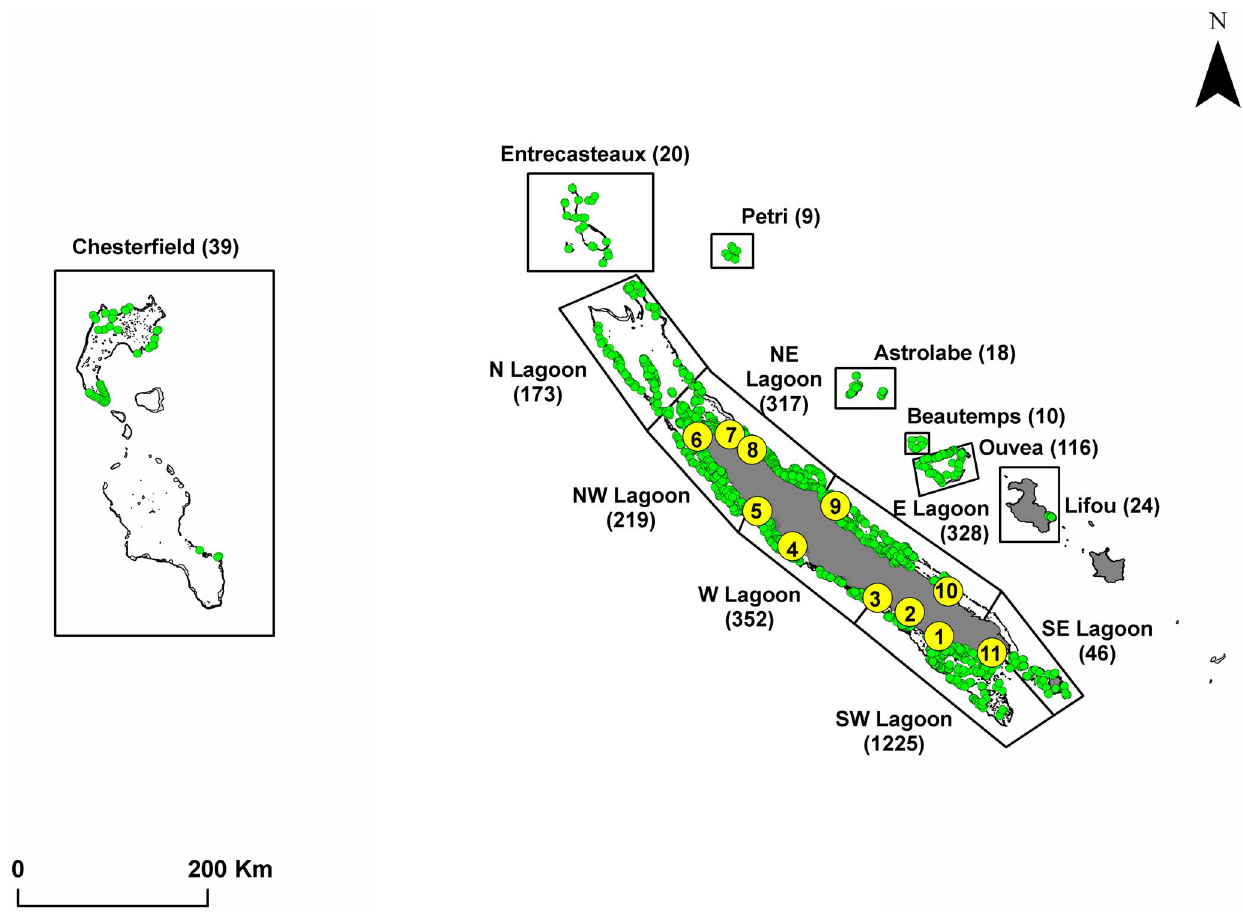
Figure 1. Map of New Caledonia with sampling sites for microchemistry (yellow circles) and underwater visual censuses (UVC, green circles). Polygons indicate the different lagoons, remote reefs and islands for which UVC data were collected; numbers indicate the number